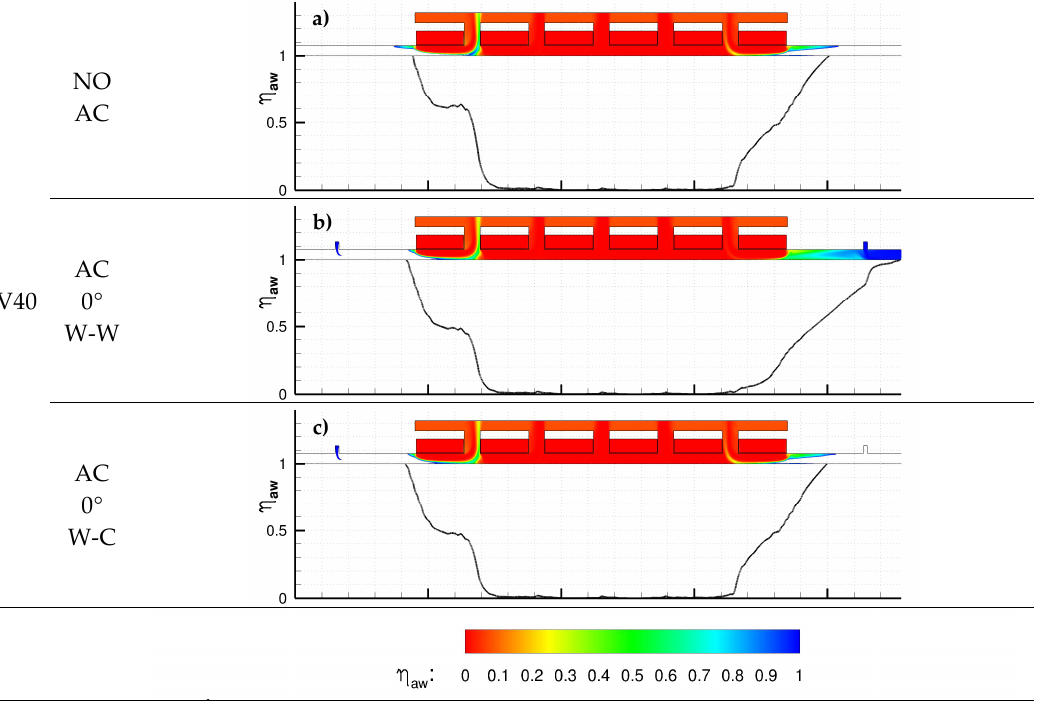
Figure 18 . Adiabatic wall effectiveness coefficient distribution for the reference configuration without air curtains and the best configuration with warm air curtains, at 40 m/min fabric speed.